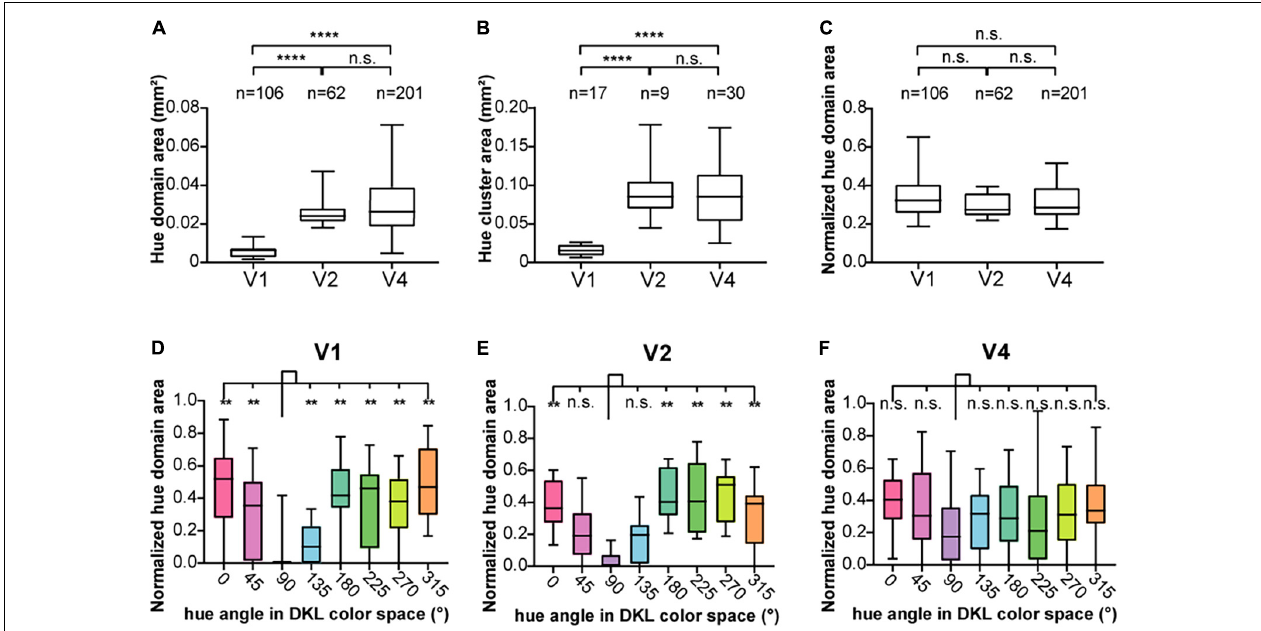
FIGURE 4 | The size of hue domains and hue clusters in V1, V2, and V4. (A) Boxplot of the areas of hue domains in the visual cortices ( n = 106, 62, and 201 hue domains for V1, V2, and V4, respectively) and their comparisons. (B) Boxplot of the areas of hue clusters in the visual cortices ( n = 17, 9, and 30 hue clusters for V1, V2, and V4, respectively) and their comparisons. (C) Boxplot of the normalized hue domain areas (the area of each hue domain divided by the area of the hue cluster to which the domain belongs) in the visual cortices and their comparisons (the statistics in (A–C) , two-tailed t test, **** P < 0.0001; n.s., P > 0.05, Bonferroni corrected). (D–F) Boxplots of the normalized hue domain areas for individual hues in V1, V2, and V4 and their comparisons between hue 90 ◦ and other hues (two-tailed t test: ** P < 0.01, n.s. P > 0.05, Bonferroni